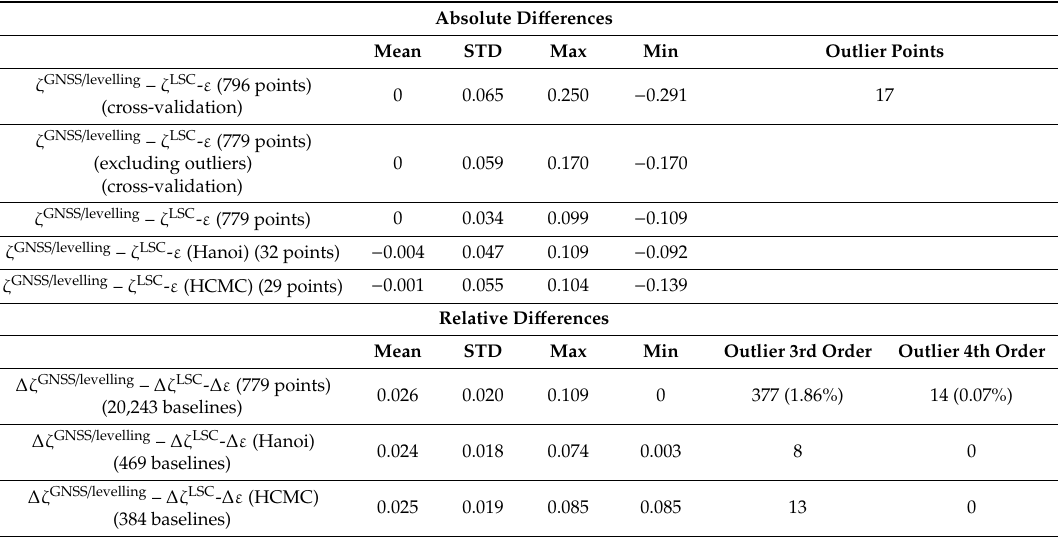
Table 6. Descriptive statistics of the di ff erences between the GNSS / levelling data and gravimetric quasigeoid adding o ff set model with baseline length < 100 km. Unit: (m). Absolute Di ff erences Mean